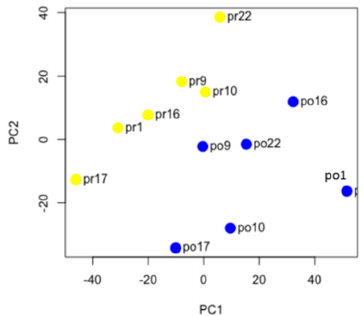
Figure 3. Principal component analysis of pre-NACT and post-NACT samples. Principal component analysis was performed using the top 6748 expressed genes in the 12 samples. Yellow dots are pre-NACT samples and blue dots are post-NACT samples. Patient ID numbers are listed.